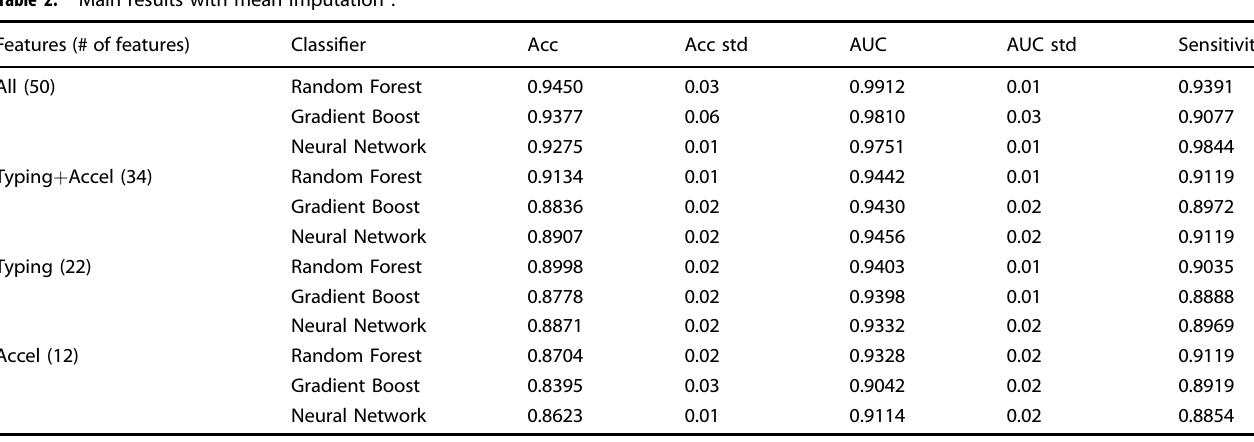
Table 2. Main results with mean imputation a . Features (# of